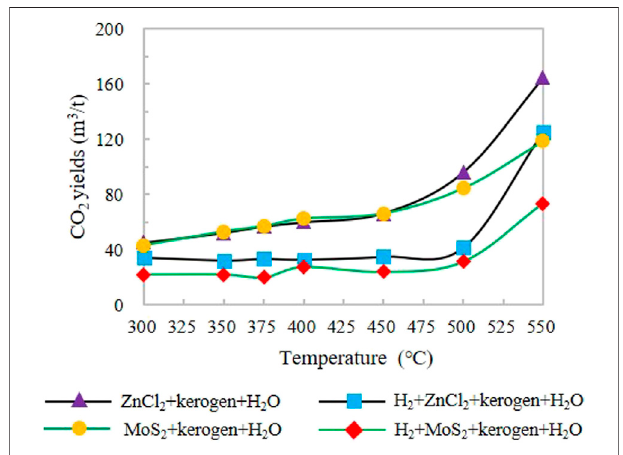
FIGURE 3 | Change in CO 2 yield simulated under different catalytic hydrogenation control conditions of the closed system.